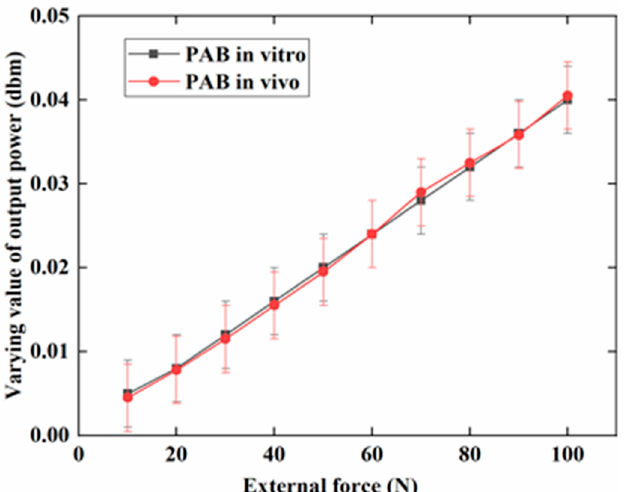
Figure 7. Varying values of the output power when an external force of 0–100 N was applied to PAB in vitro and in vivo (repaired sheep leg).